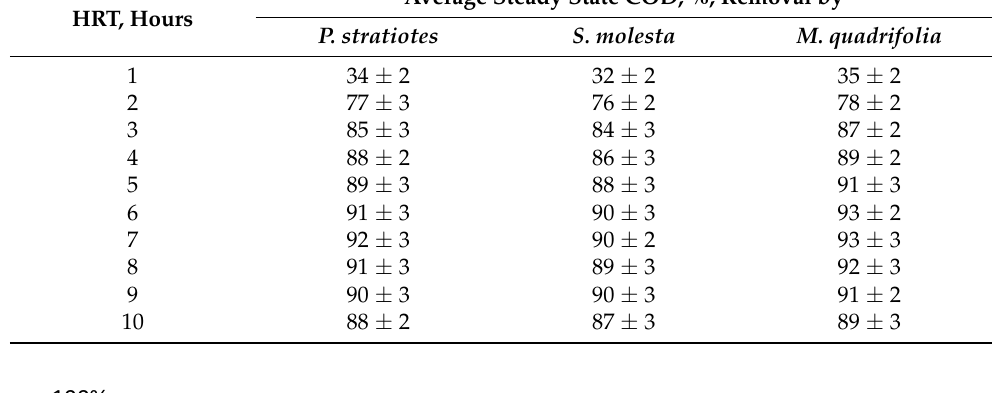
Table 3. Average COD removal at steady state in SHEFROL at different HRTs by the three macro- phytes.